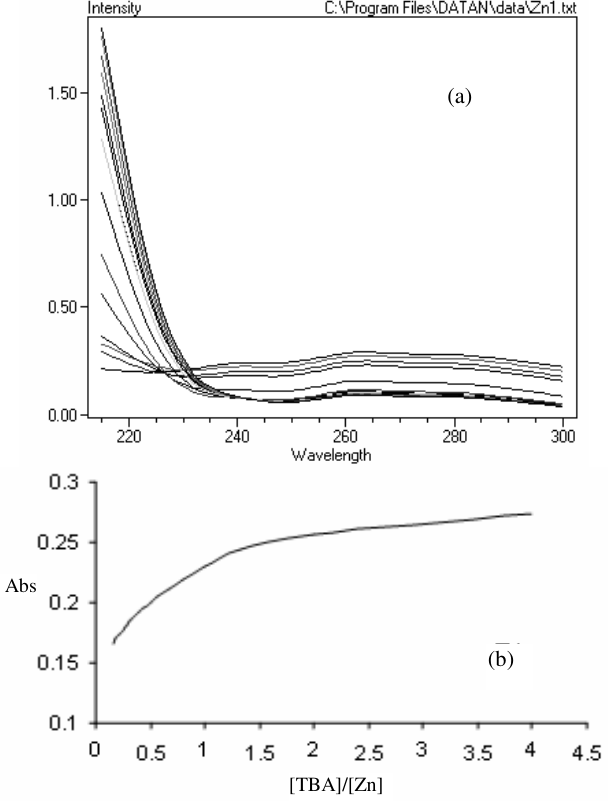
Figure 4. UV-Vis spectra for titration of TBA (1 × 10 -5 M) with Zn 2+ (5 × 10 -4 M) in deionized = 264 nm, T = 25 o C, pH = 6) (a) and the corresponding water (Ic = 0.2 (%w/v) NaCl, λ max molar ratio plot